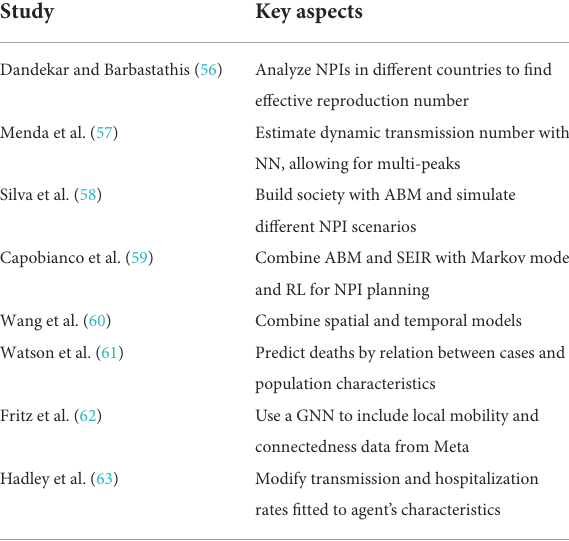
TABLE 5 Included studies covering spatio-temporal monitoring of disease spread with hybrid models and their key